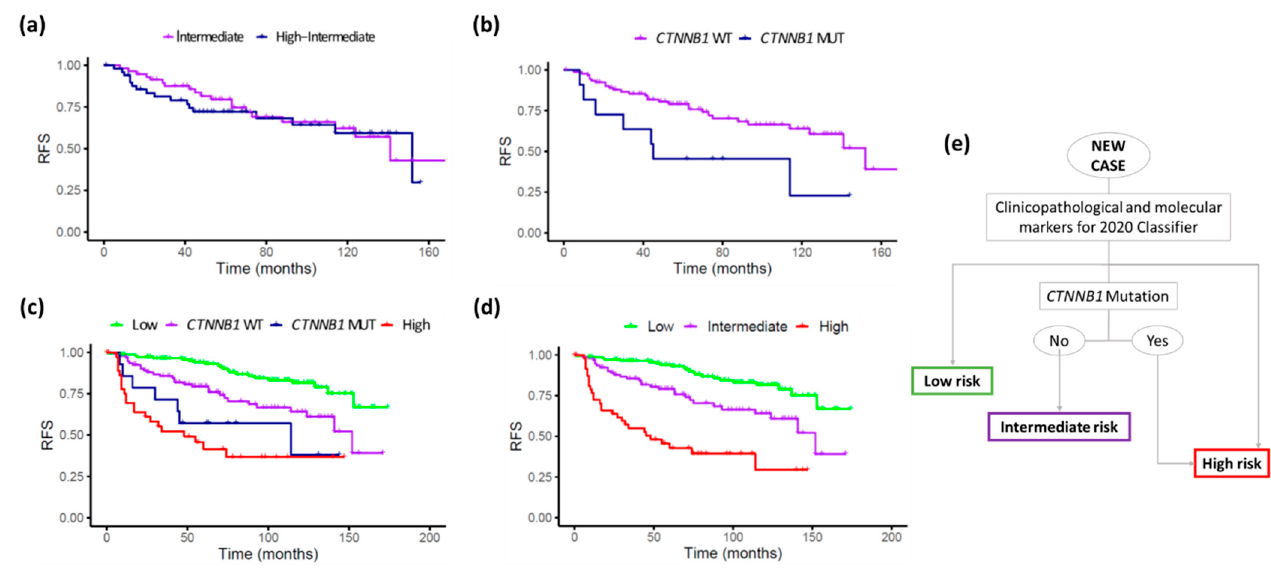
Figure 3. KM relapse-free survival plots for the new risk stratification proposal. ( a ) Intermediate and high-intermediate groups following the 2020 Classifier criteria; ( b ) merged intermediate groups stratified by CTNNB1 status; ( c ) entire series, including high and low-risk groups based on 2020 Classifier criteria and intermediate groups stratified by CTNNB1 status; and ( d ) entire series with the new proposal, stratified in 3 groups, by adding those with CTNNB1 mutation to the high-risk group. ( e ) Decision tree based on this proposal.